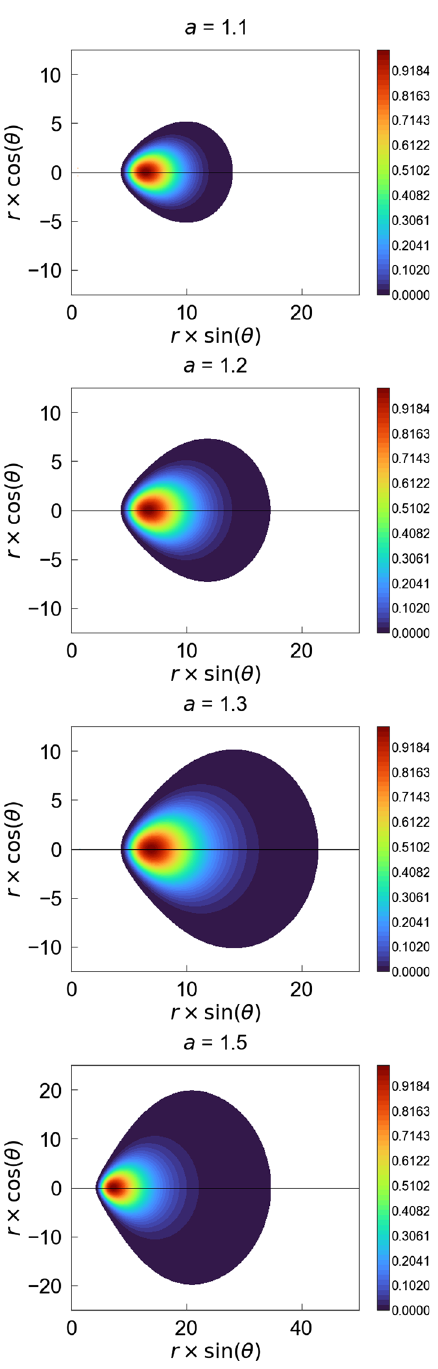
Fig. 12 Equidensity surfaces for various values of a in the Kerr metric Fig. 13 Equidensity surfaces for various values of a in the naked Kerr